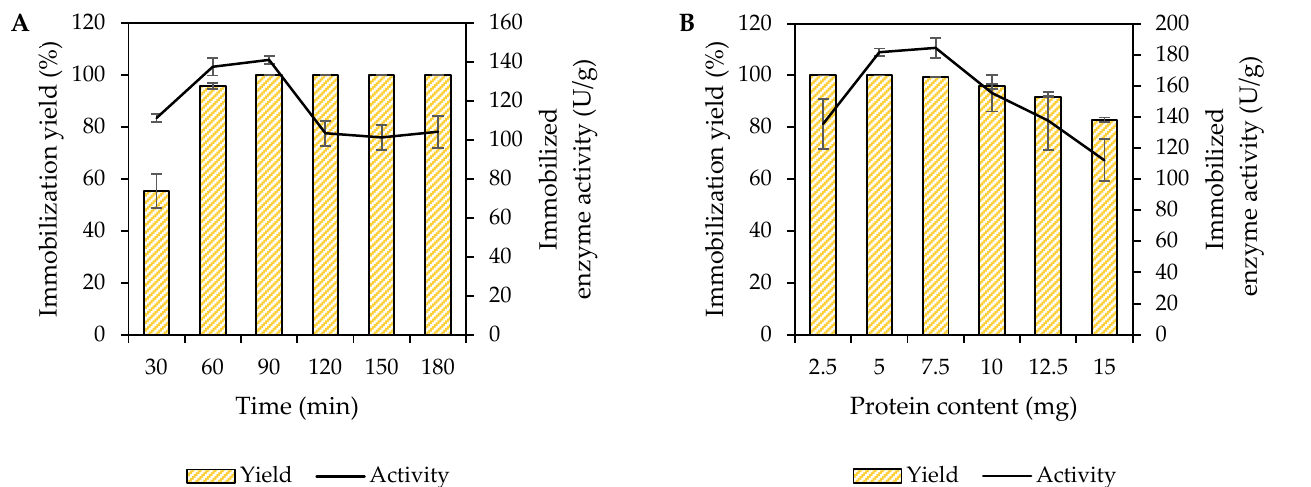
Figure 1. Immobilization optimization of carboxylic acid reductase from Mycobacterium phlei ( Mp CAR). ( A ) Effect of immobilization time on immobilization yield (%) and immobilized enzyme activity (U/g). The purified Mp CAR (5 mg) was immobilized onto 1 g of Seplite LX120 at different immobilization times at 30 min intervals. ( B ) Effect of protein load on immobilization yield (%) and immobilized enzyme activity (U/g). Different protein contents (with 2.5 mg intervals) were loaded for their 90 min of immobilization onto Seplite LX120. The immobilization was performed at room temperature with a stirring speed of 250 rpm. Samples were measured in triplicates.